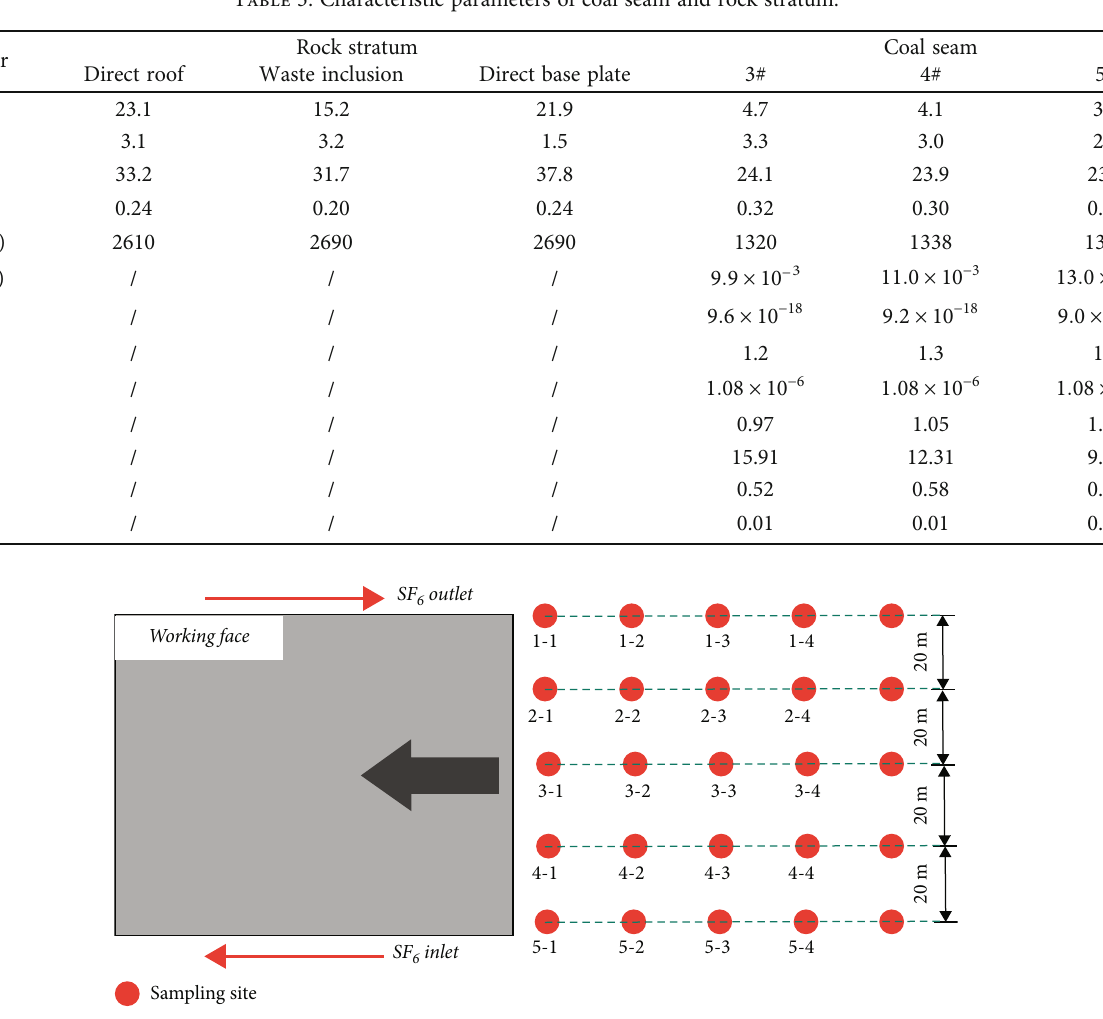
Table 3: Characteristic parameters of coal seam and rock stratum.